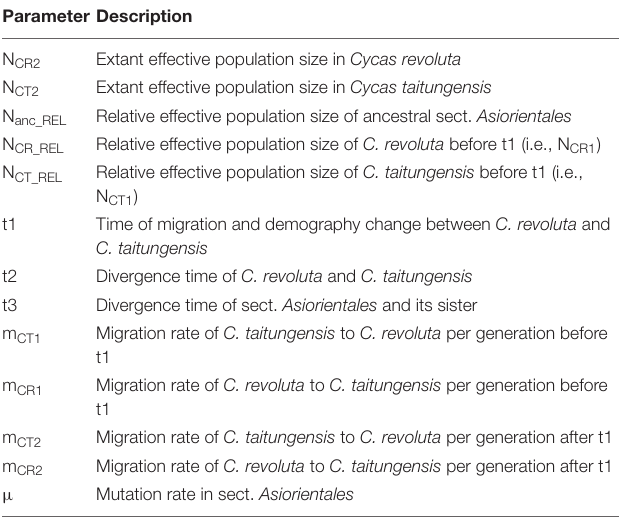
TABLE 1 | Description of the model parameters in the four speciation models. Parameter